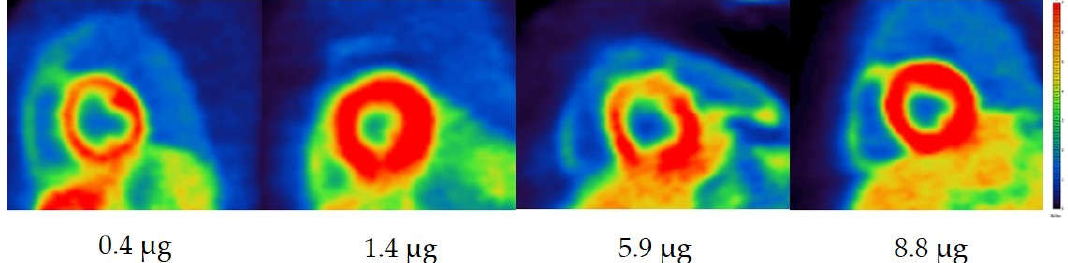
Figure 4. Cardiac images (short axis orientation) of Morbus Fabry patients with different applied mass doses of metaraminol and m HED. The sum of metaraminol and m HED is shown beneath the respective image. The patient with abnormality of sympathetic innervation was excluded in the figure, showing a Myo/Med ratio of <4 with an applied mass dose of 4.5 µg. The correlations using the SUV mean for the heart transplantation patients (HTX) showed again no significance for the Myo/ivBP ( p -values between 0.3 and 0.6), as well as for the Myo/Med ( p -values range from 0.4 to 0.6) ratios (data not illustrated). Moreover, no relationship was found using the